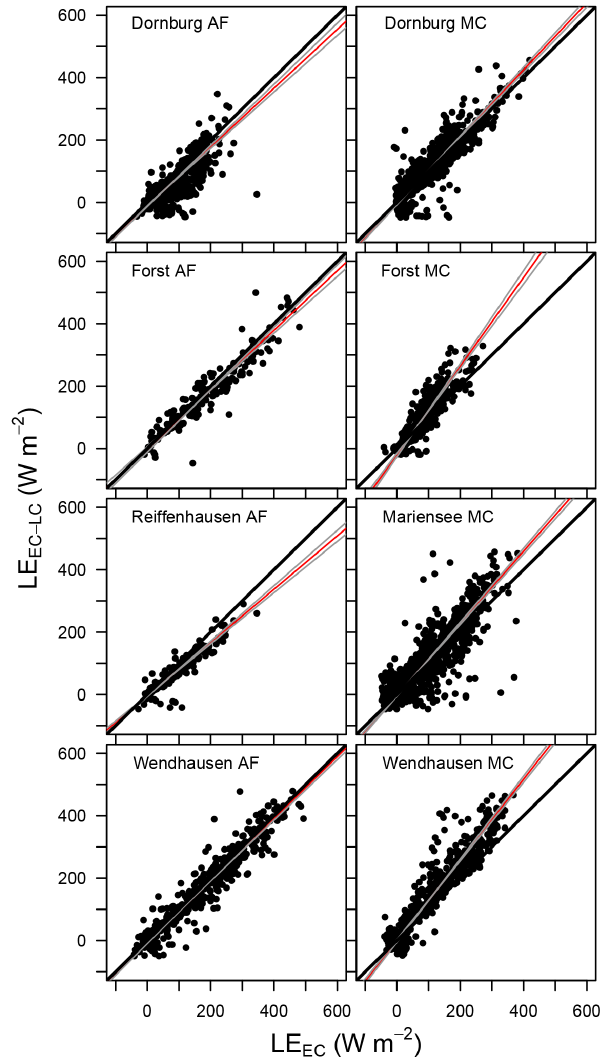
Figure C2. Scatter plot of LE ECEB vs. LE EC for all sites. The red line denotes the best fit line, with grey lines as the ± 2 . 5% confi- dence interval lines, and the solid black lines corresponding to the 1:1 line. Data from Reiffenhausen MC are missing due to the un- availability of a campaign.